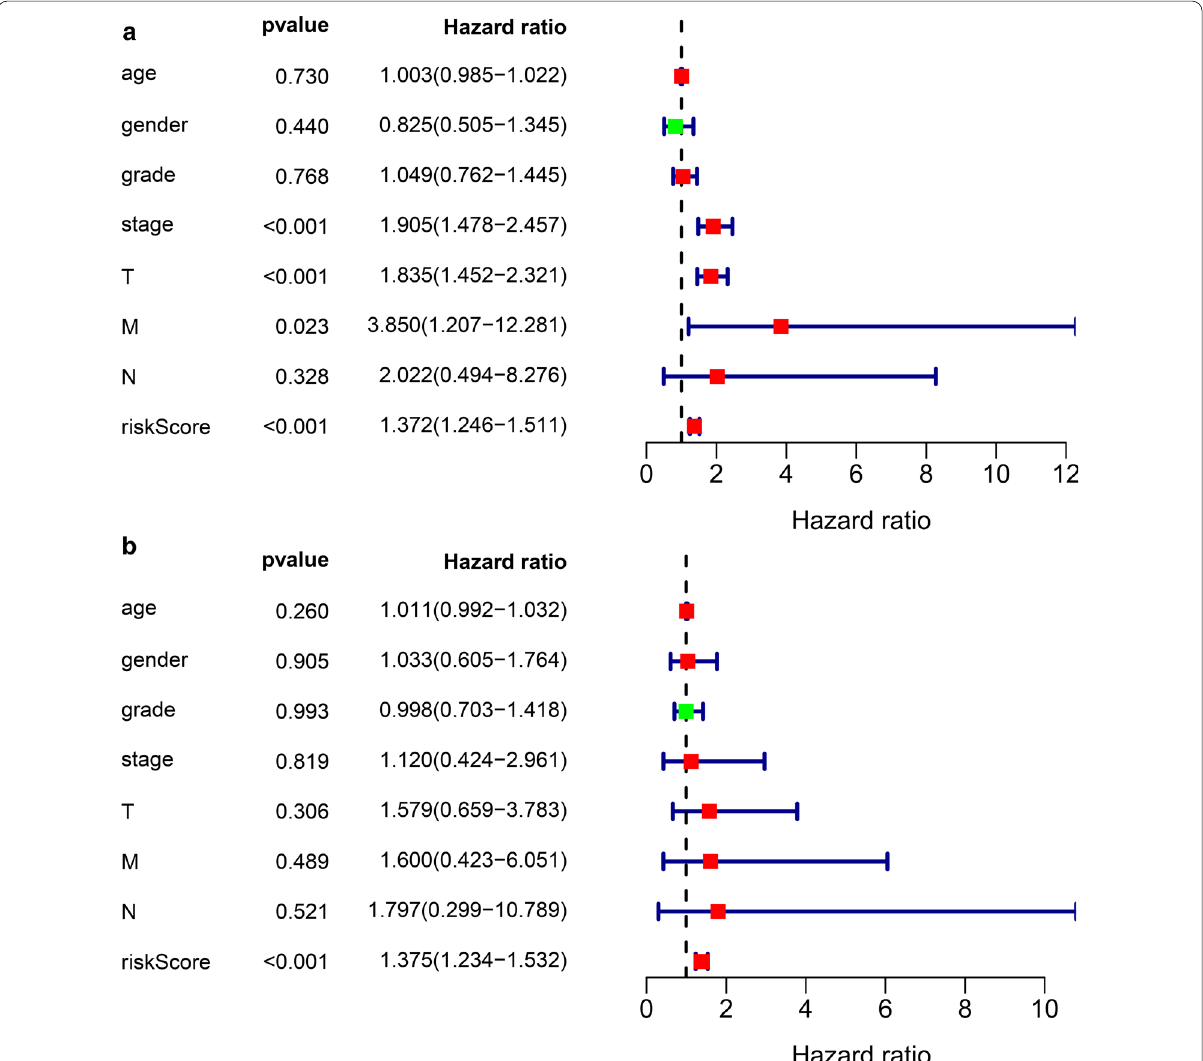
Fig. 6 Independent prognostic analysis. a Univariate factor independent prognostic analysis. b Multivariate factor independent prognostic